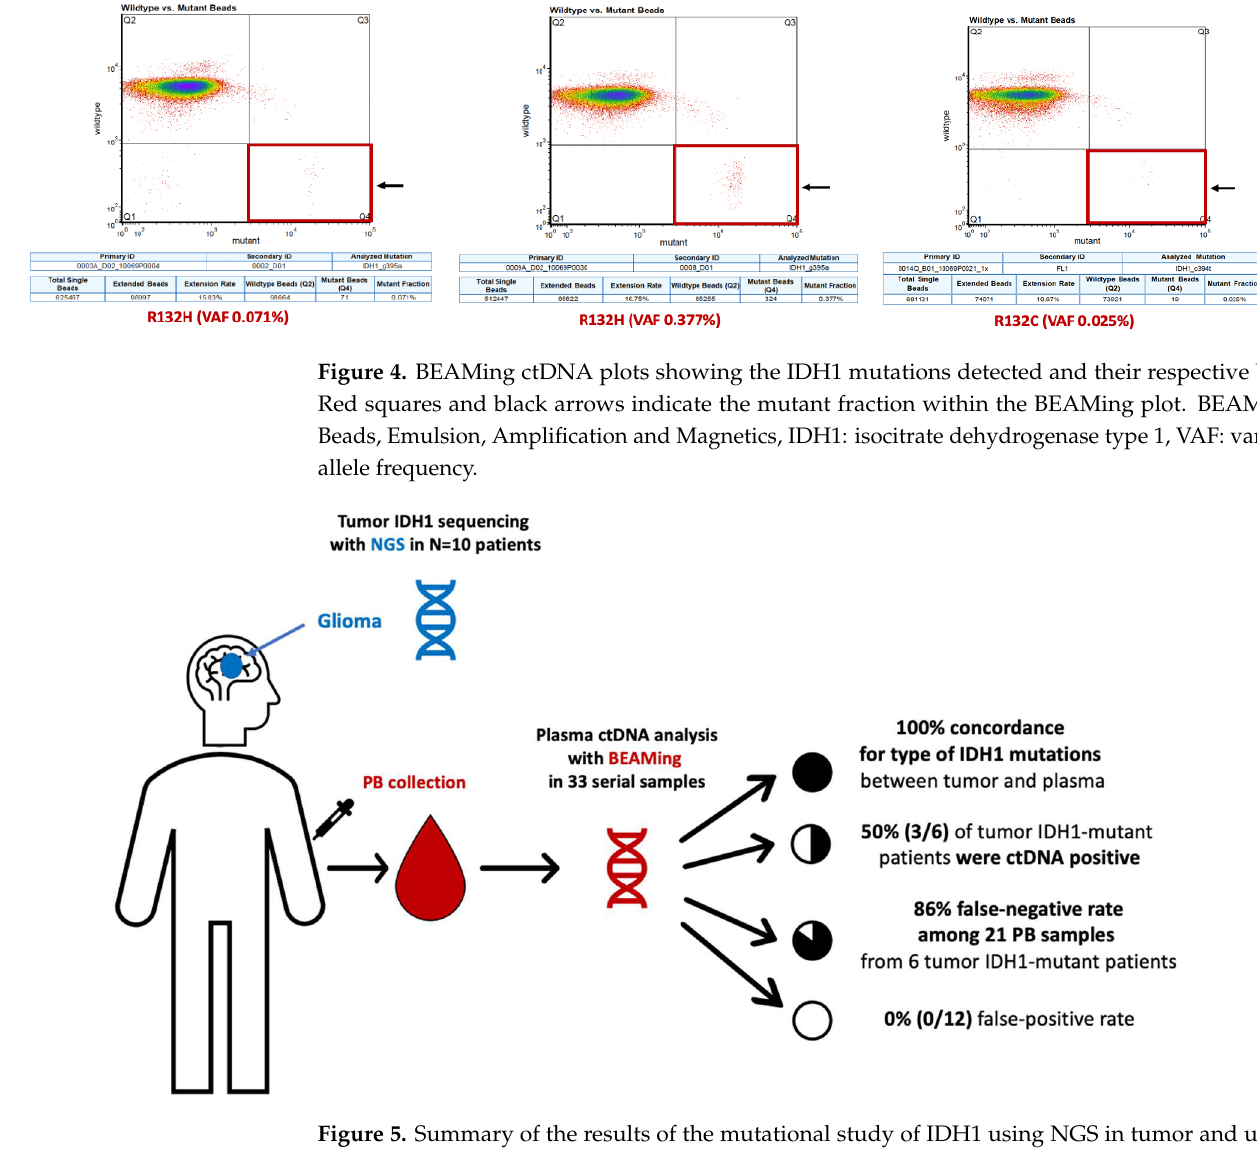
Figure 5. Summary of the results of the mutational study of IDH1 using NGS in tumor and using BEAMing in plasma in patients with gliomas. BEAMing: Beads, Emulsion, Amplification and Magnetics, IDH1: isocitrate dehydrogenase type 1, PB: peripheral blood.